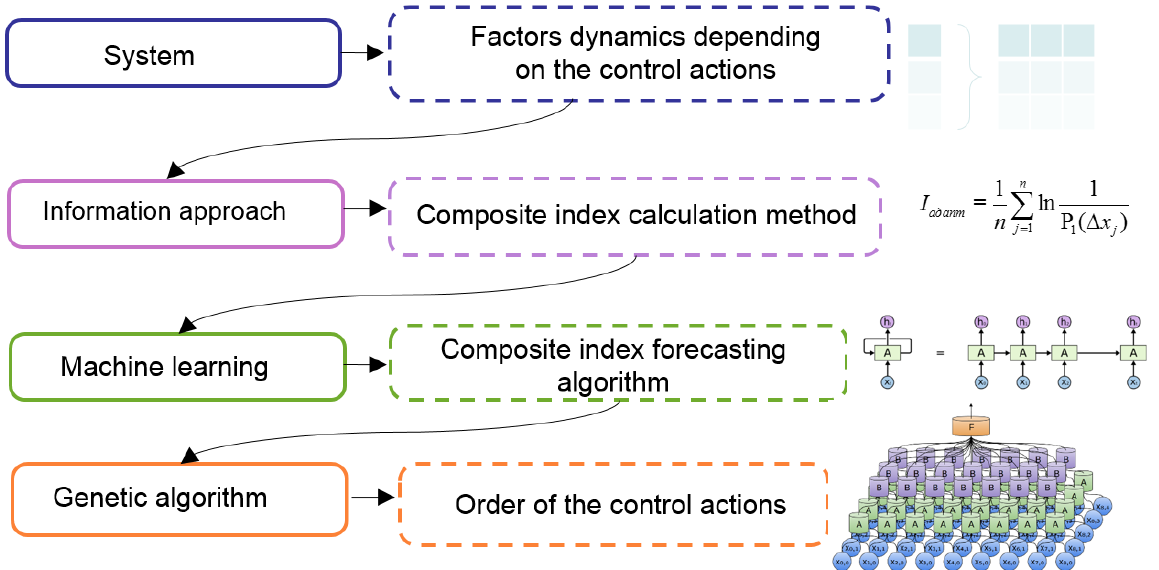
Fig. 2. The concept of choice of control